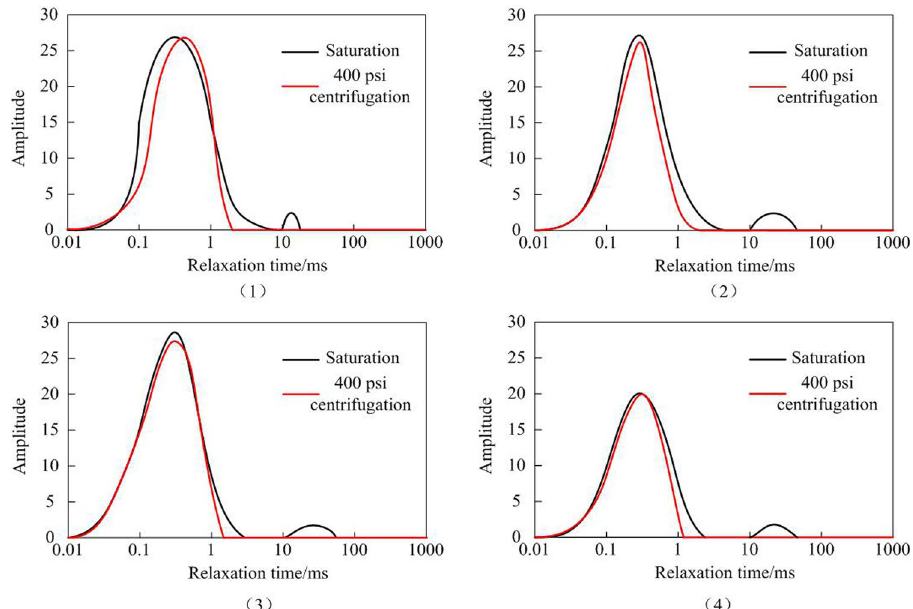
Fig. 4 T 2 distribution diagrams of samples